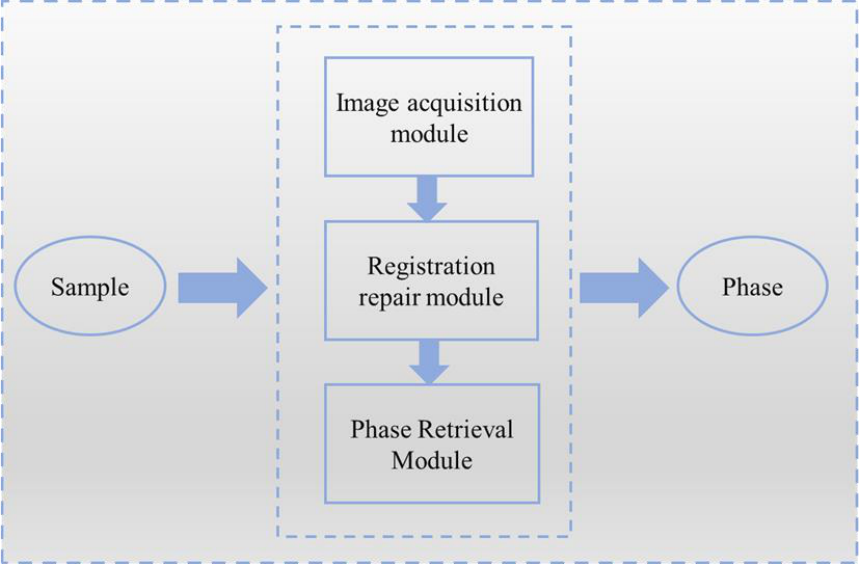
Figure 1. Phase retrieval imaging technology based on